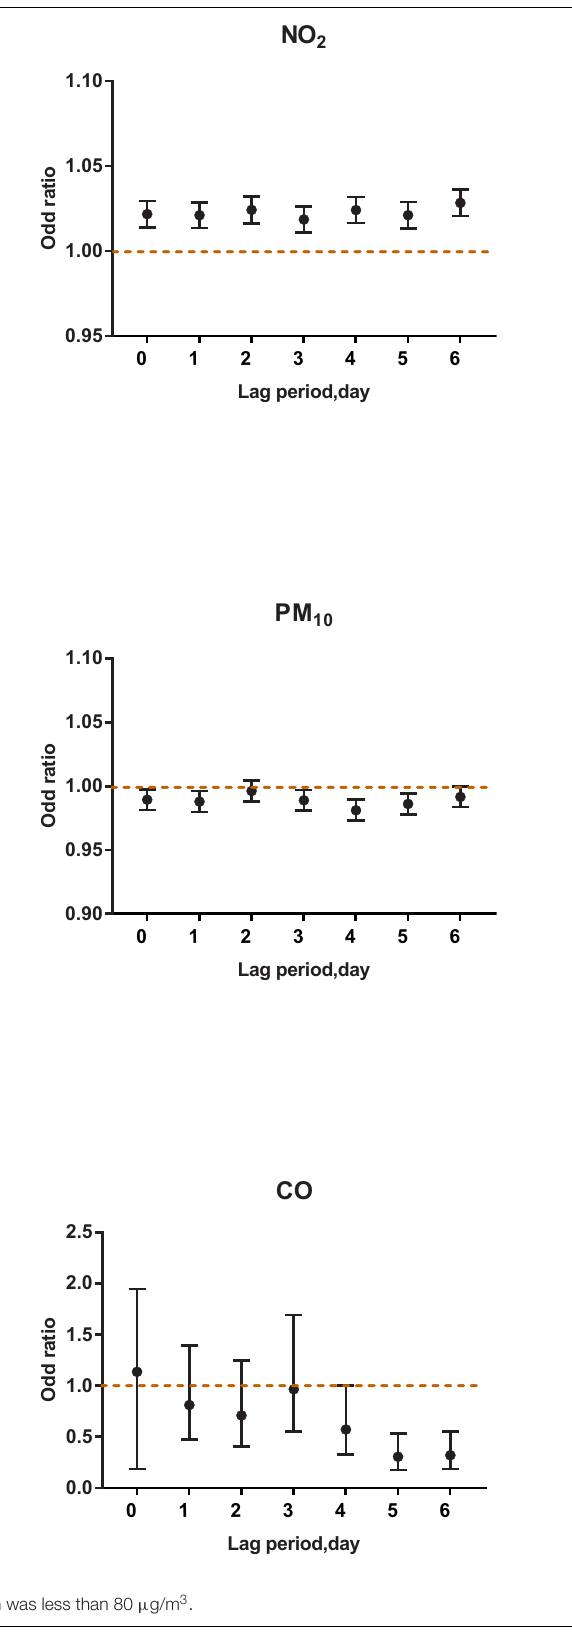
Frontiers in Pediatrics |